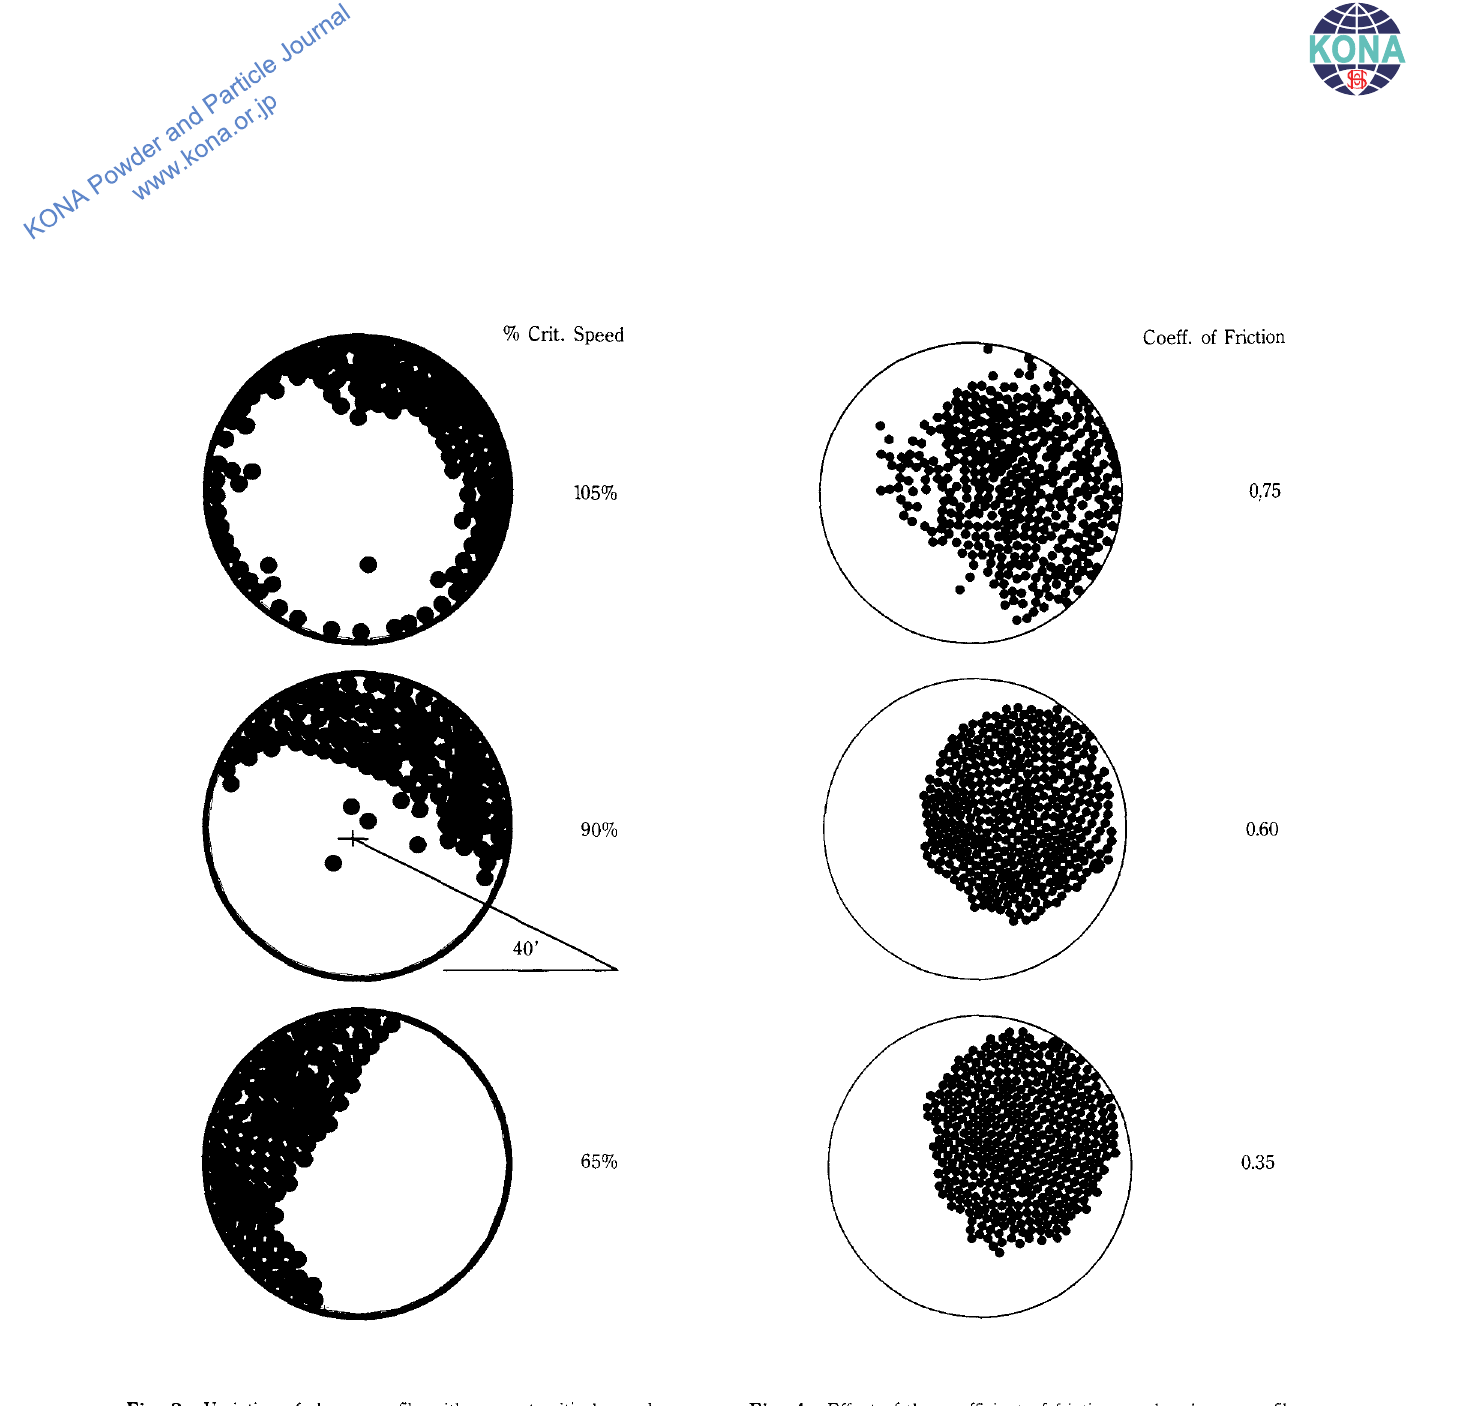
Fig. 3. Variation of charge profile with percent critical speed. Fig. 4. Effect of the coefficient of friction on the charge